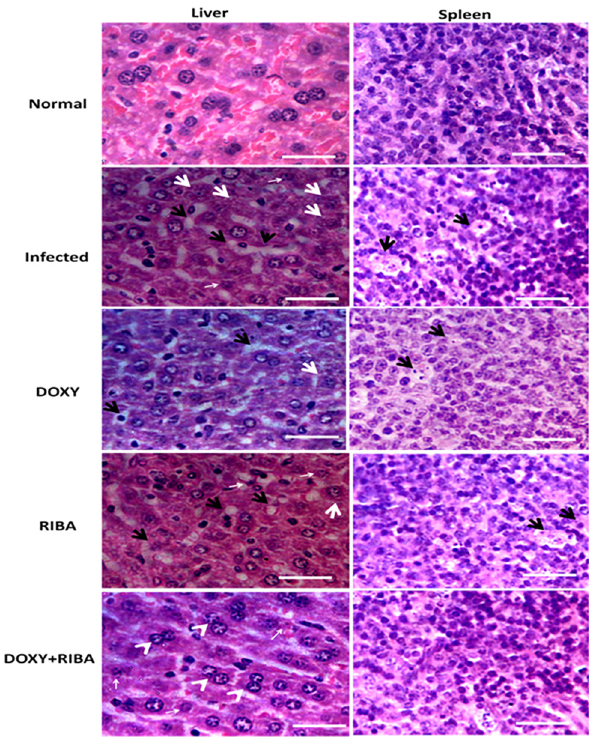
Fig 6. Histopathology of the liver and spleen of CHIKV-infected mice after the treatment with DOXY-RIBA. The liver of infected mice showed accumulated infiltrated fluid due to inflammation (black arrows), many swollen hepatocyte (white arrows) and few shrinking apoptotic cells (small arrows). DOXY- or RIBA- treated mice showed reduction in abnormal cells and inflammation. DOXY+RIBA showed lesser shrinking apoptotic cells (small arrows) while other infection features disappeared. The existence of binucleate hepatocytes indicated accelerated liver cell renewal (arrowheads). The spleen of infected mice showed shrinking apoptotic cells and accumulated infiltrated fluid due to inflammation (black arrows), and this symptoms were reduced due to treatment with DOXY+RIBA (scale bars 50 μ M).